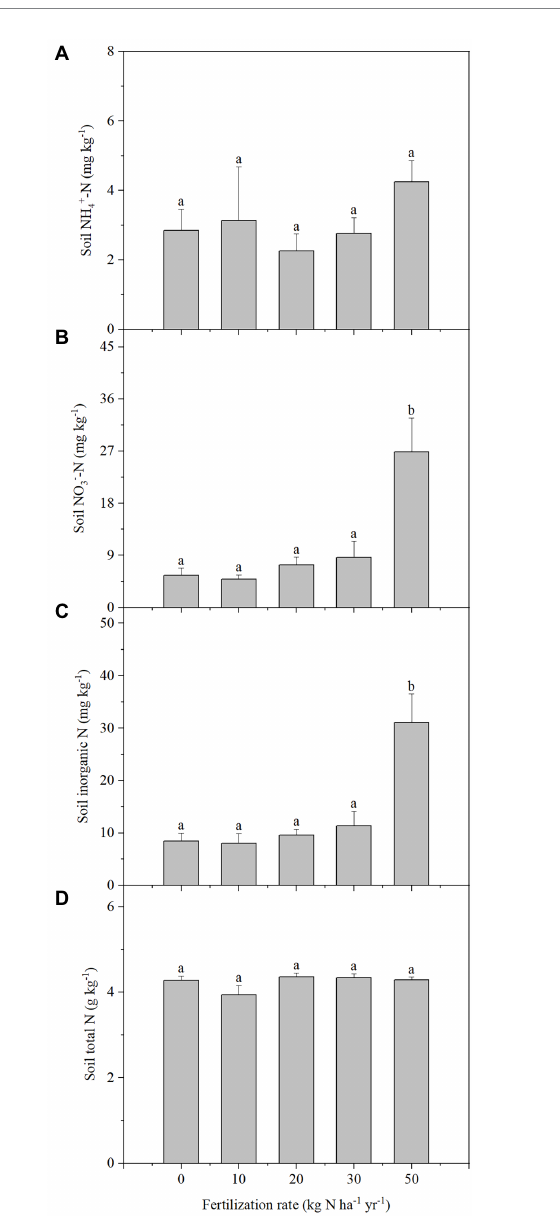
FIGURE 4 NH 4+ (A) , NO 3 − (B) , inorganic N (C) , and total N (D) concentration of pot soils in which Stipa breviflora plants were grown under different N addition rates at 120 DAS. Each value is the mean of four replicates (+SD). Different lowercase letters indicate significant differences among the treatments at p <